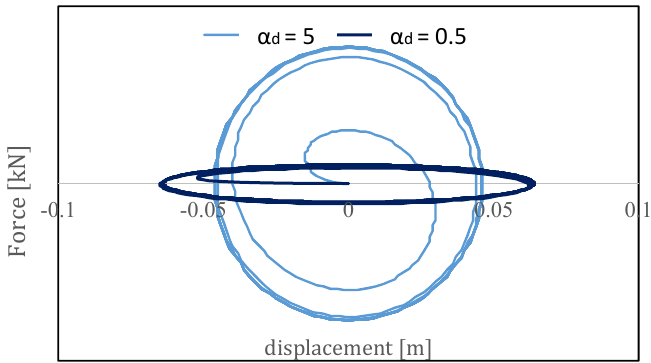
Figure 7. Viscous dissipative loops for sinusoidal force in viscous damper with α d = 0.5 and α d = 5